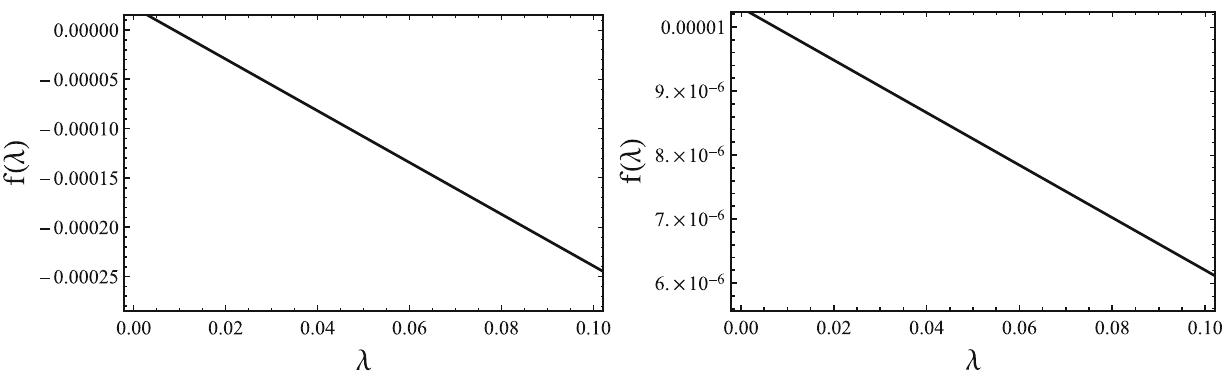
Fig. 2 From left: f (λ) for δ J ψ (cid:9) δ Q and δ J ψ (cid:10) δ Q against λ for the given values of the test particle and black hole parameters